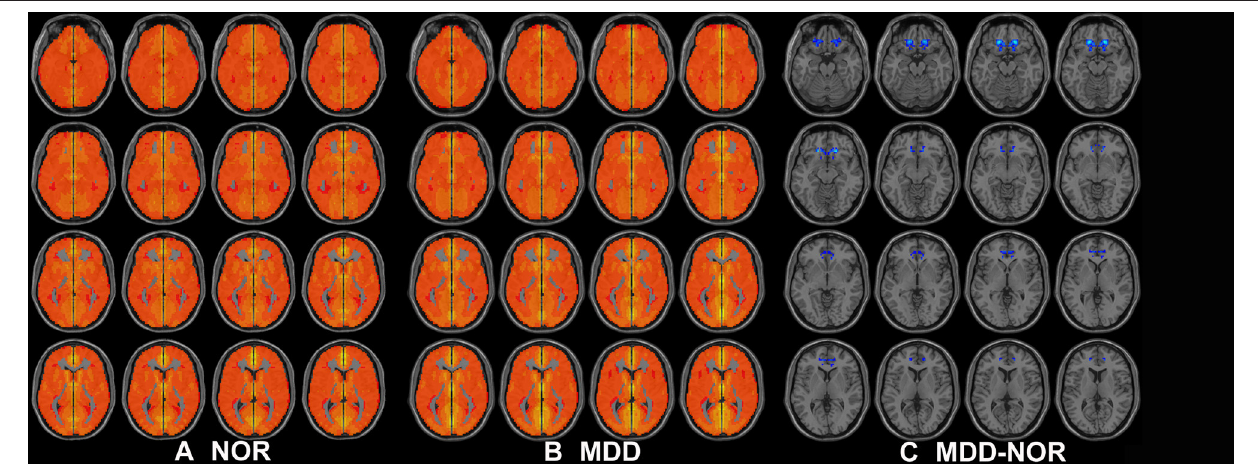
FIGURE 2 | Axial MRI scans show interhemispheric FC within and between groups. Regions show significant interhemispheric FC in (A) healthy controls and (B) MDD patients ( P < 0.05, AlphaSim corrected). (C) Homotopic regions show decreased (cool color) FC in the MDD group ( P < 0.05, AlphaSim corrected).